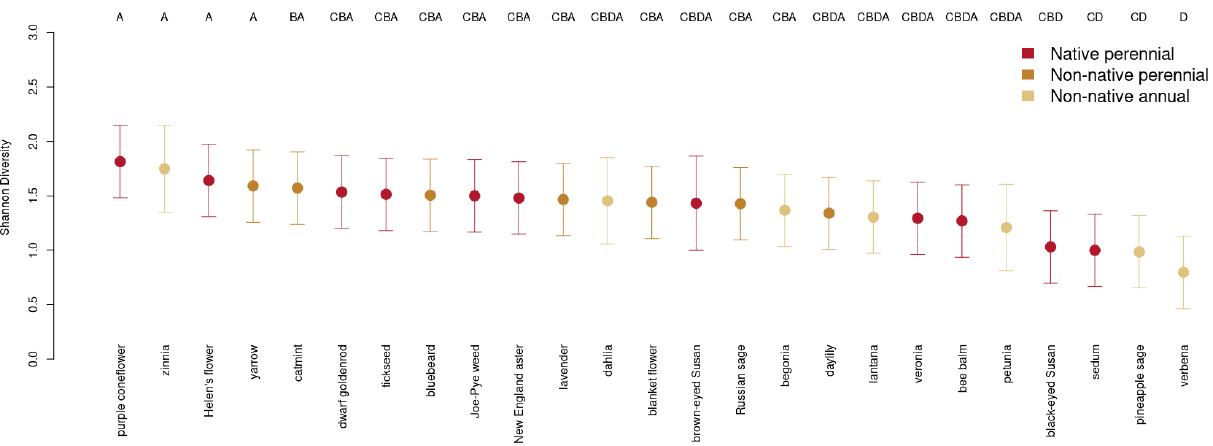
Figure 4. Ornamental plants significantly impact the diversity of insect visitors. The x axis displays the ornamental plants in our study, and the y axis displays that plant’s diversity score (95% CI), as calculated with the Shannon’s Diversity Index. Post hoc mean separation test results are displayed as letters on top of the figure, and datapoint colors denote whether the plant was a native perennial, non-native perennial, or non-native annual.